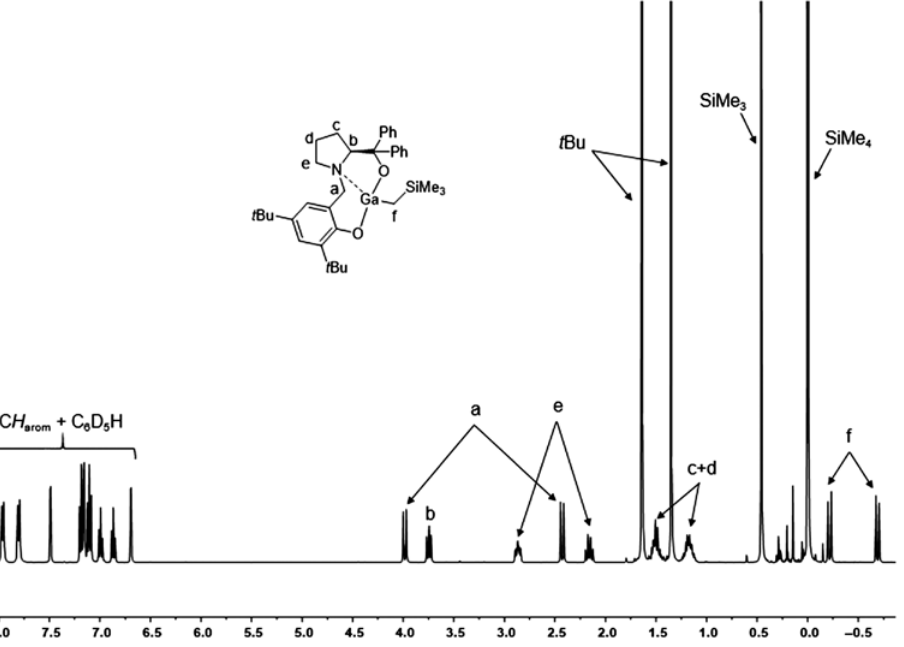
, 500.1 MHz, 298 K) of ( S )-{OˆO}GaCH 6